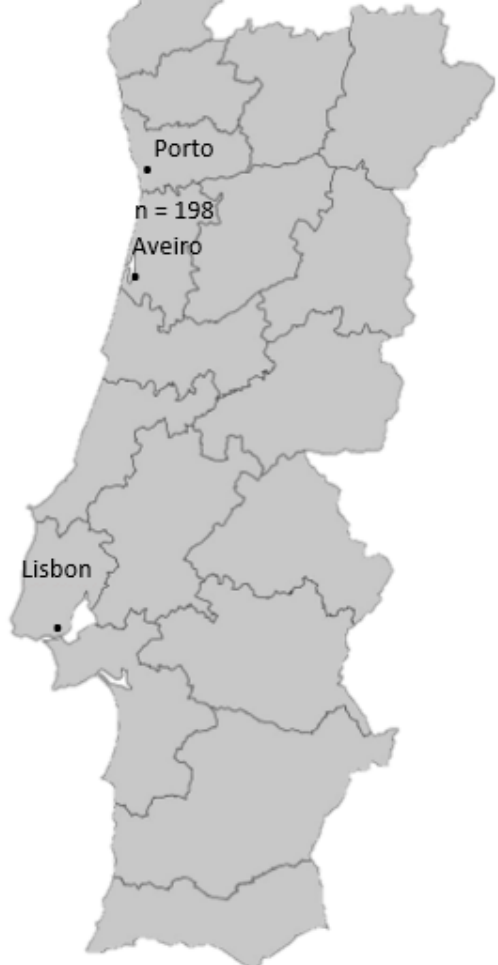
Figure 1. Location of the municipality of Aveiro in mainland